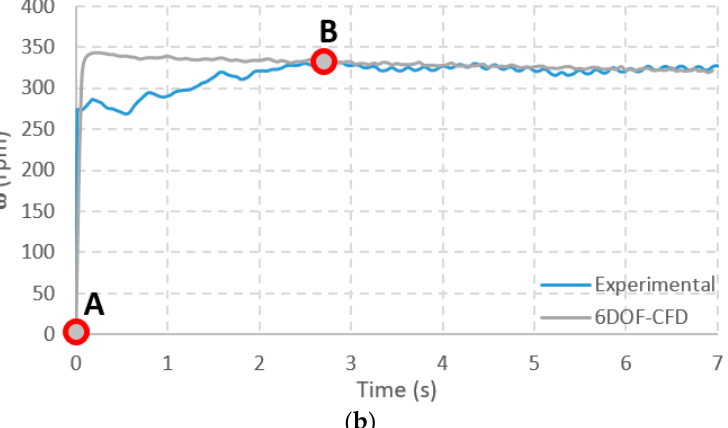
Figure 11. The variation in the rotor’s angular speed: ( a ) The time span from rest to 40 s, ( b ) Zoom in for the accelerating zone. (for explanation of points A-C, refer to figure 8.a)